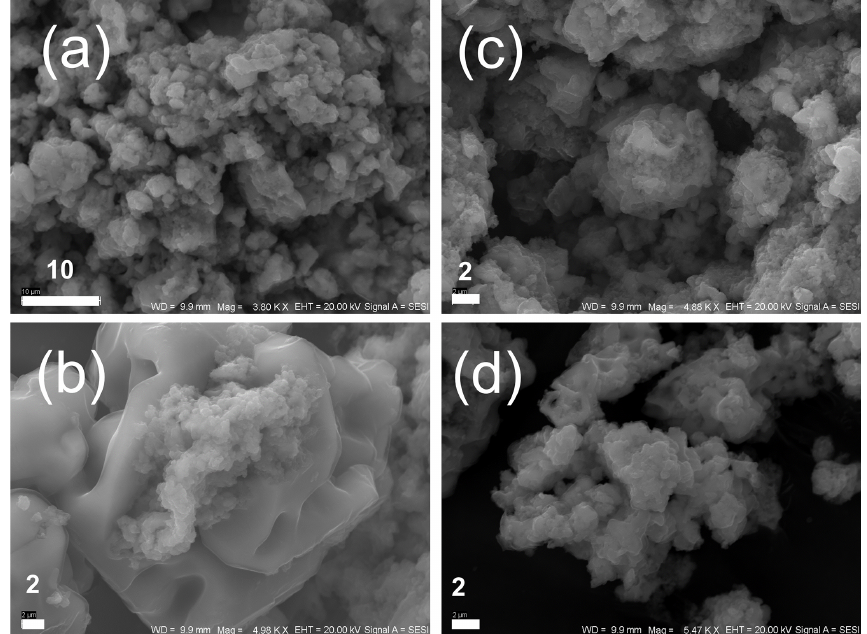
Figure 7. FeS precipitates under SEM after experiments with (cid:56) 6 phage. (a,b) Minerals obtained in experiment under mixing conditions; (c,d) minerals precipitated under static (without mixing) conditions. The bar indicates scale in micrometres